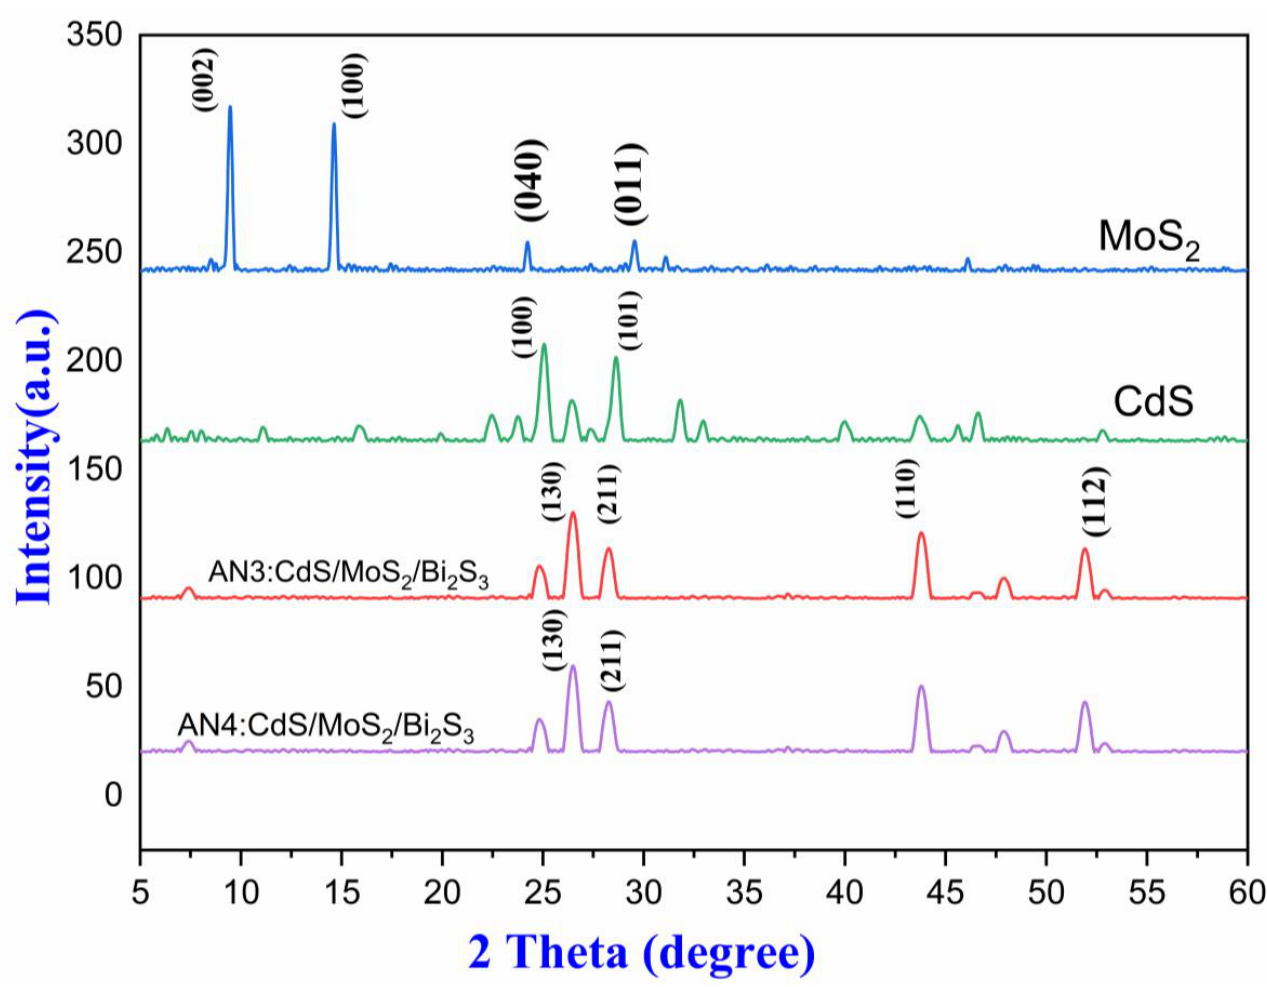
Figure 3. XRD spectra (CdS, AN3, AN4, and MoS 2 ).